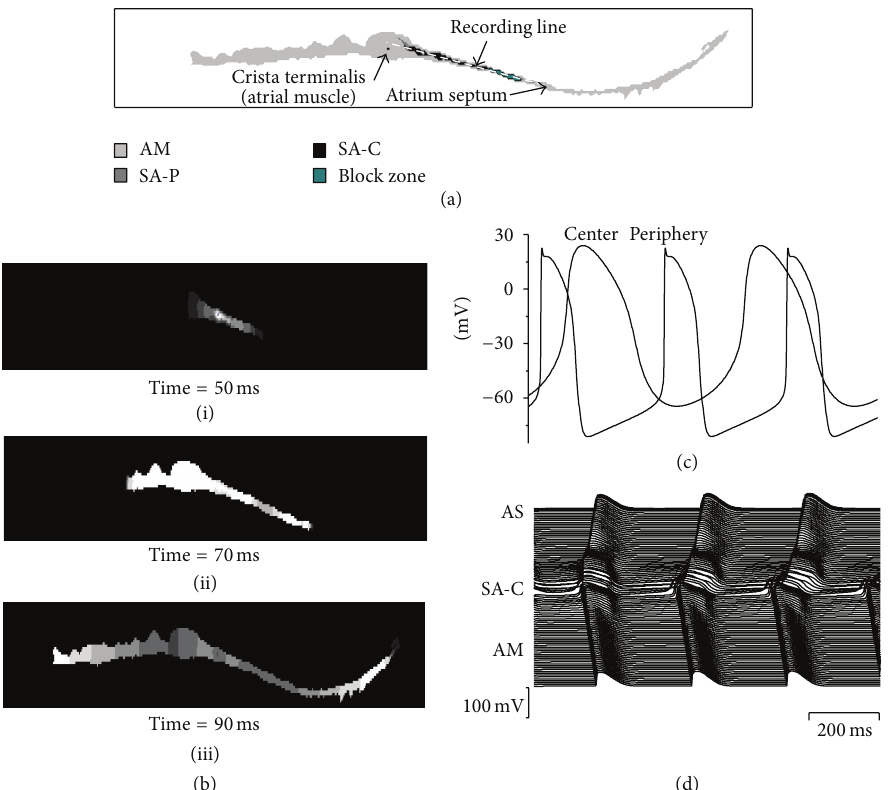
Figure 1: Model of the SAN and surrounding atrial tissue. (a) Color-coded distribution of cell types throughout the 2D tissue slice. (b) Snapshots of initiation and conduction in 2D anatomical model at various times after initial configuration; (i) 50ms; (ii) 70 ms; (iii) 90 ms. (c) Action potentials in one cell of the central and peripheral SAN. (d) Action potential profiles during conduction through the slice. As, atrial septum; SA-C, SAN center; AM, atrial muscle (CT).